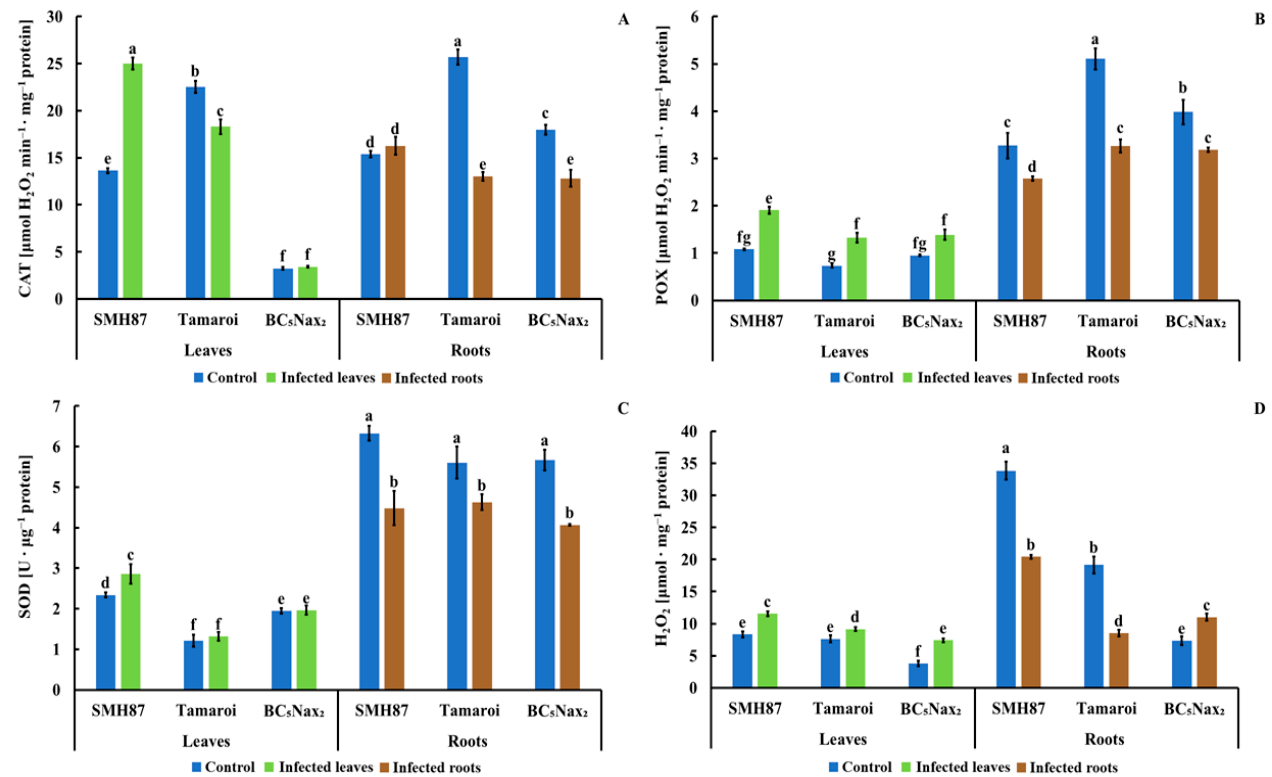
Figure 5. Effects of F. culmorum infection on catalase ( A ), peroxidases ( B ), and superoxide dismutase ( C ) activity, and H 2 O 2 ( D ) content in the leaves and roots of three durum wheat accessions. The values represent means ( n = 3) ± SE. Different superscript letters ( a–g ) for each organ indicate significant differences between means (Duncan’s multiple range test; p < 0.05).